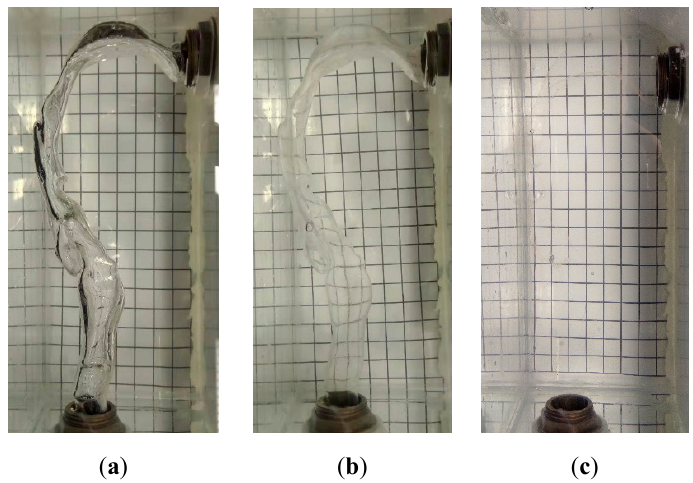
Figure 3. Optical index matching between ETA model and working fluids: ( a ) air; ( b ) water; ( c ) mixture of water and glycerol.